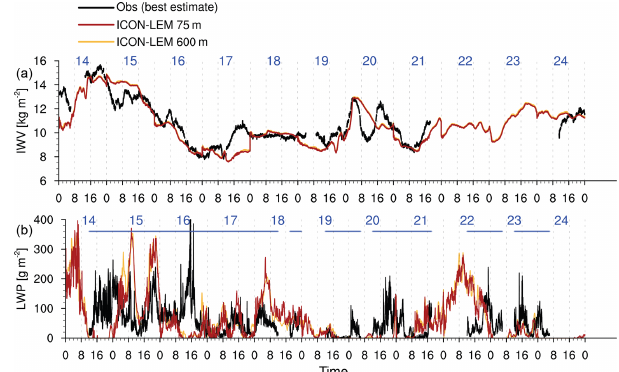
Figure 3. Time series of observed (black) and of ICON-LEM sim- ulated (600m, yellow; 75m, red) IWV (a) and LWP (b) . Blue lines show data availability of the